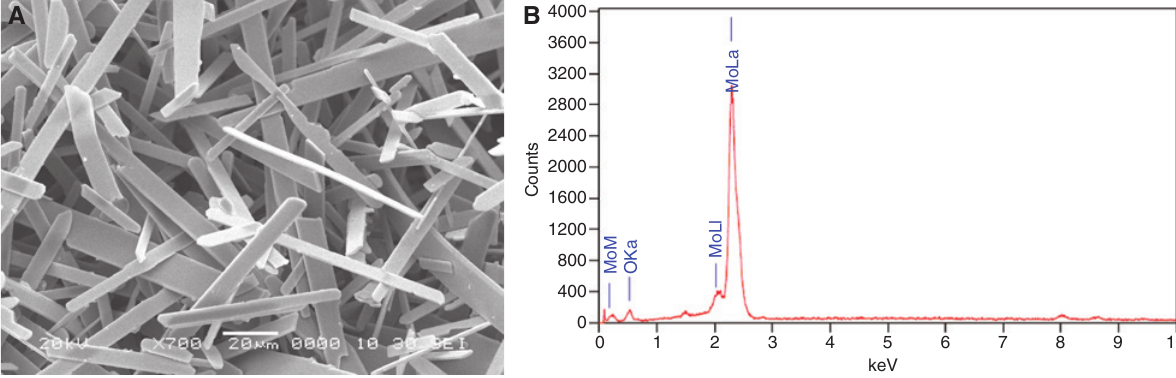
Figure 4: (A) Scanning electron microscopy (SEM) micrograph and (B) energy dispersive X-ray spectroscopy (EDS) of MoO